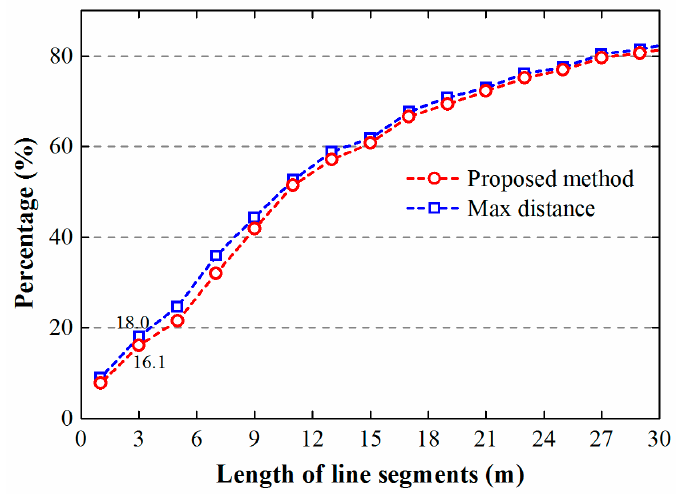
Figure 9. Cumulative percentage of line segments of polygons.